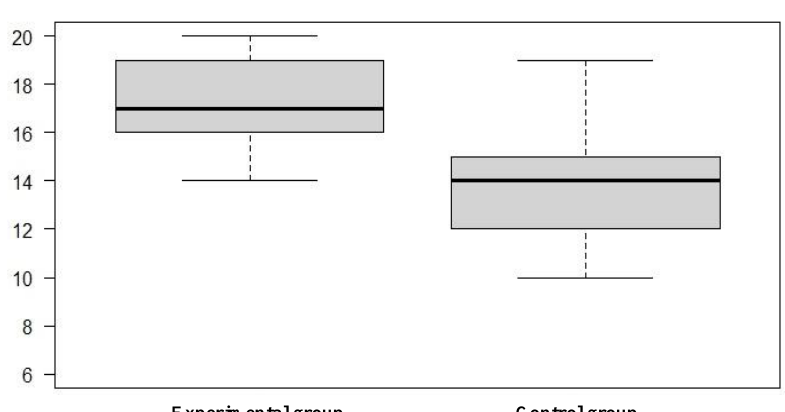
Figure 4. Hypothesis 3 – Communication